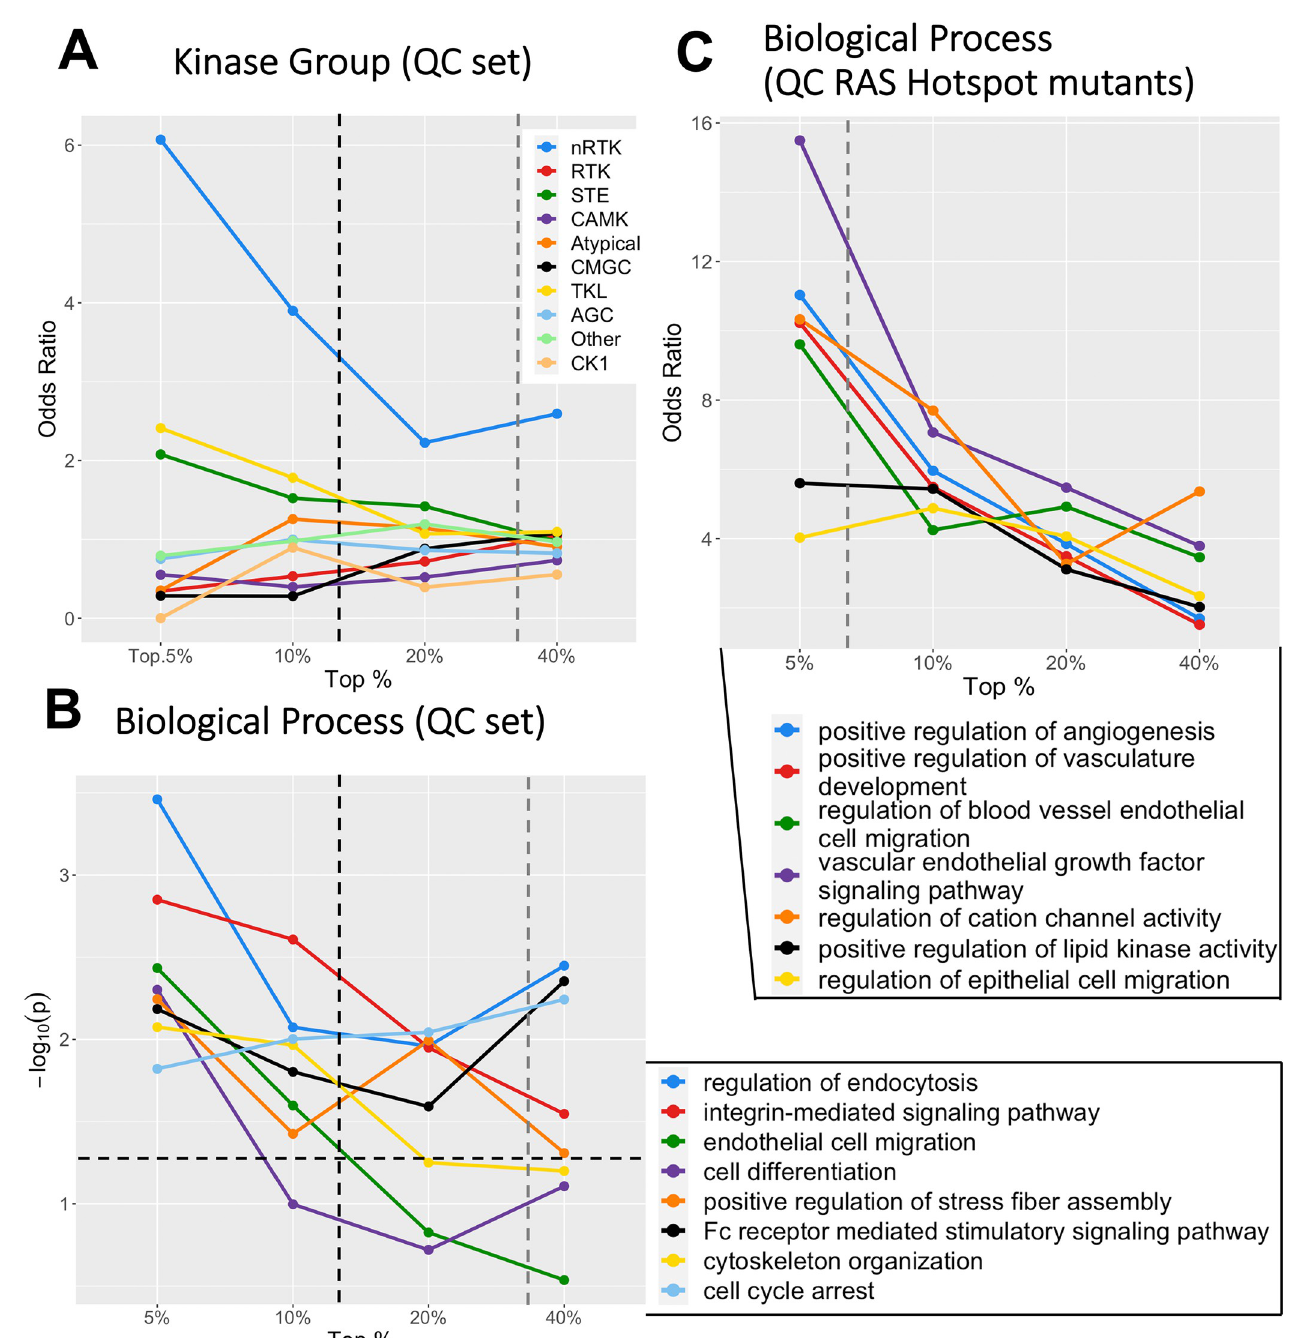
Fig 5. Genes with significant DIR display unique BP enrichment patterns. (A) DIR genes are enriched for non-receptor tyrosine kinases in the QC set, whereas there was no kinase group enrichment in the full sample set. The black dotted line indicates the percent of genes with p adj < 0.05, and the gray dotted line the percent of genes with unadjusted p < 0.05 (B) Select biological process enrichments for the QC set. Note that significance is plotted (-log ratios, and the horizontal dotted line indicates p = 0.05. (C) When using the QC RAS hotspot mutant samples only, DIR genes were highly enriched for angiogenesis and related